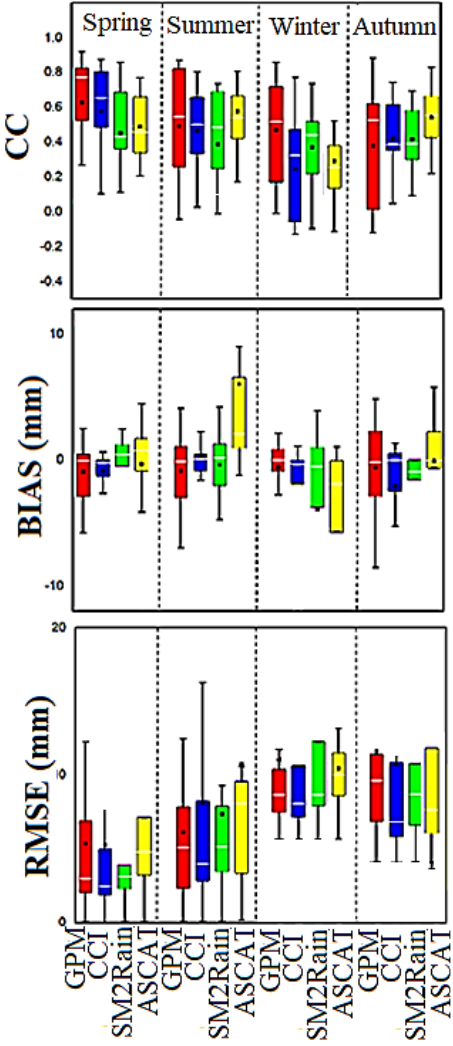
Figure 10. Box schemes of all evaluation indices on seasonal scale.